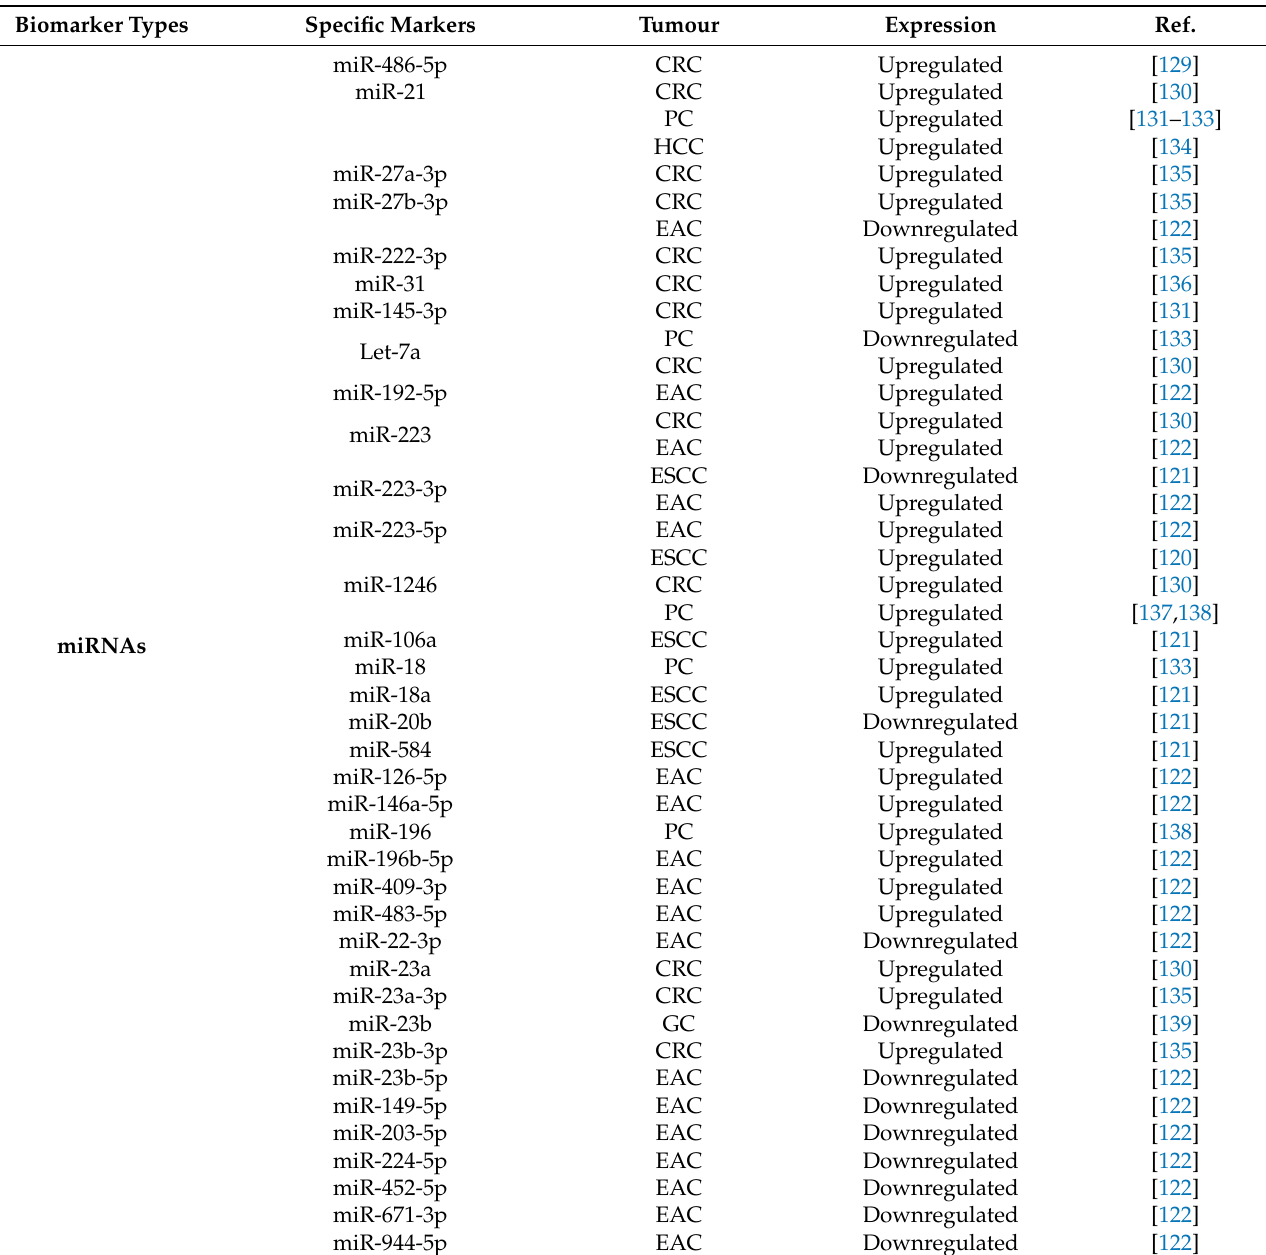
Table 6. EVs as potential biomarkers in gastrointestinal